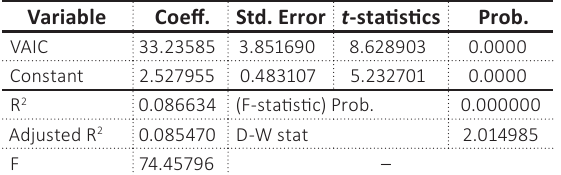
Table 7. Model 1 (OLS results)